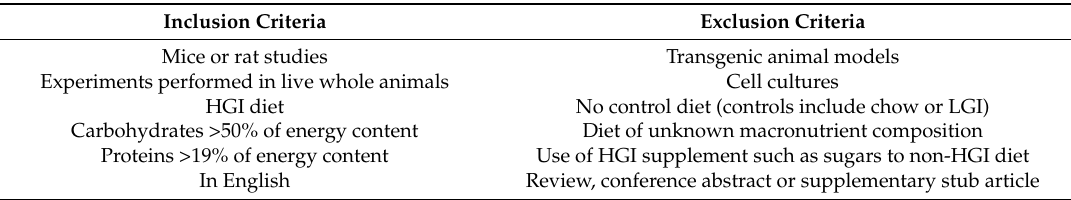
Table 1. Inclusion and exclusion criteria. This criterion was used to assess all articles and determine their eligibility for inclusion in this review. HGI, high glycaemic index; LGI, low glycaemic index.